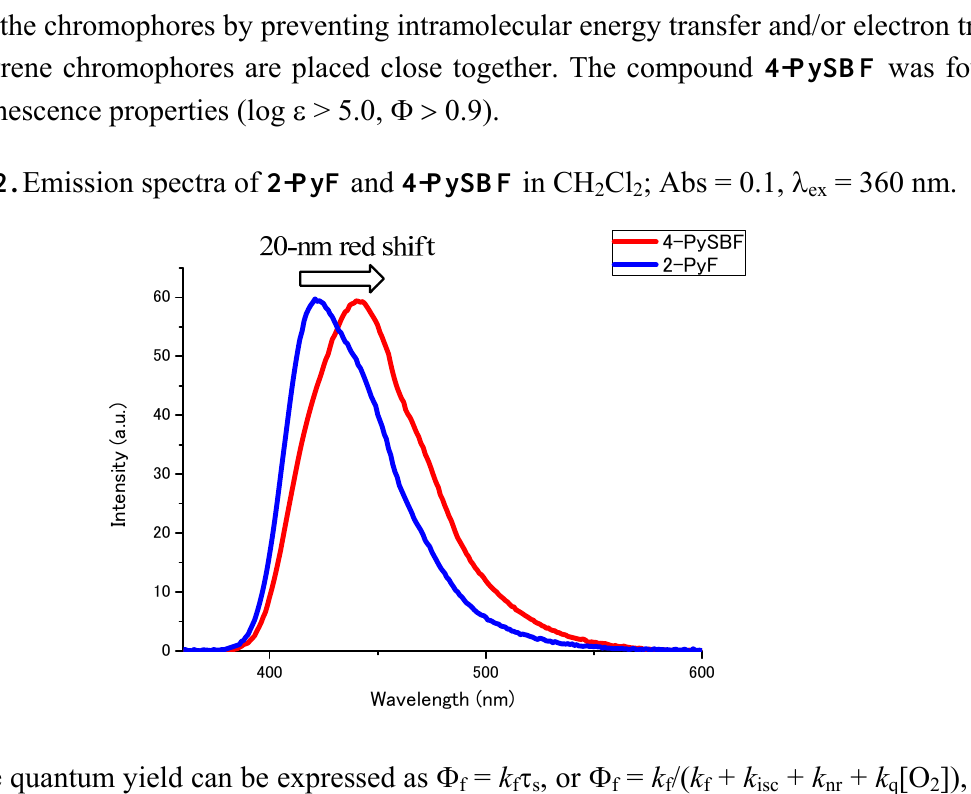
Figure 2. Emission spectra of 2-PyF and 4-PySBF in CH